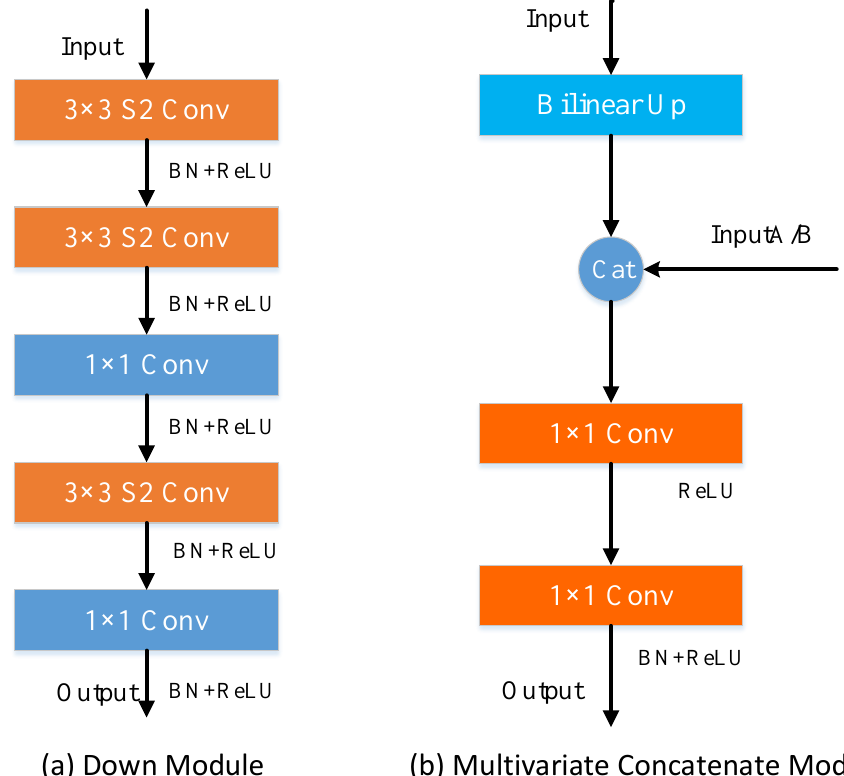
Figure 4. Down sampling module and multivariate concatenate module (S2 conv block denotes a convolution block with a stride of